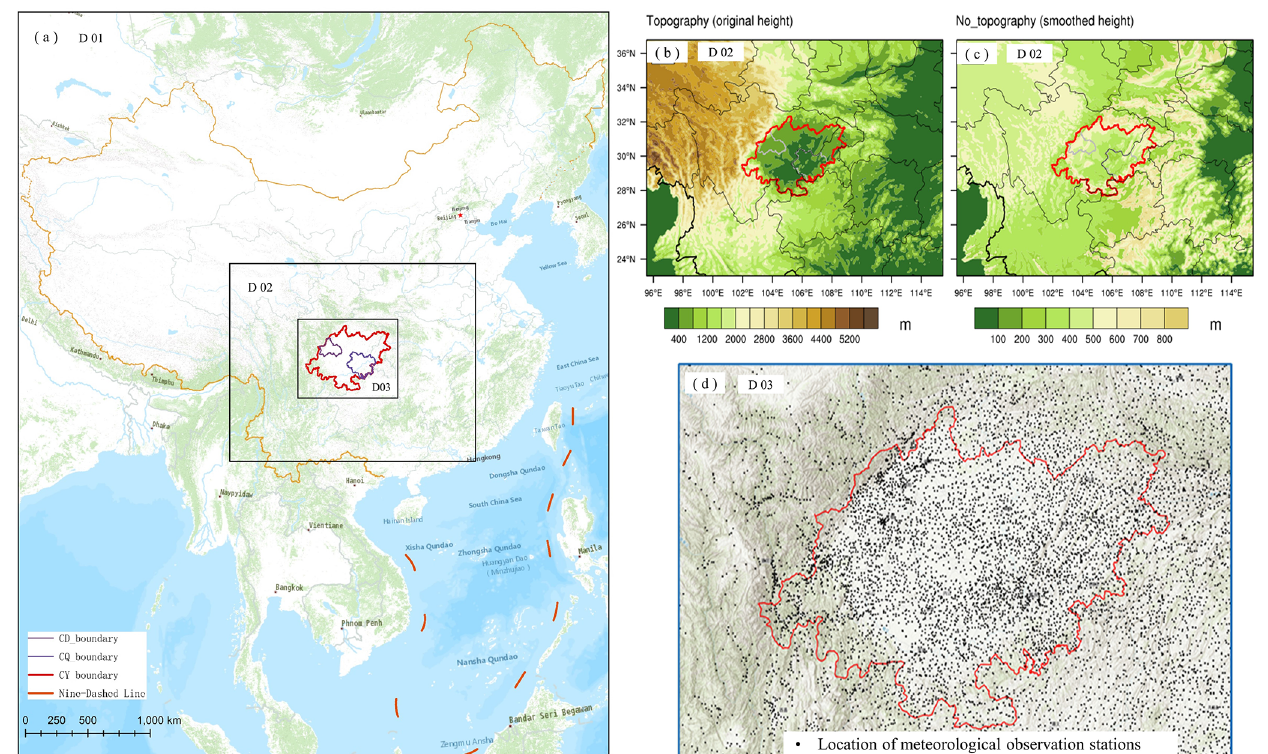
Figure 1. (a) Configuration of the three nested domains for WRF simulation. (b) The original terrain in the simulated area (m) and (c) after smoothing the terrain. (d) Location of meteorological observation stations. (The basic elevation and topographic shadow maps of Fig. 1a and d are derived from the ArcGIS Online of